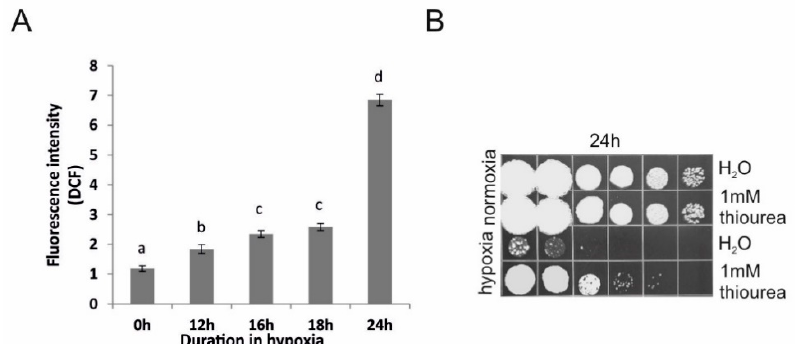
Figure 5. Production of ROS induce cell death under limited aeration. ( A ) ROS generation determined by measurement of DCF fluorescence. U. maydis cell suspensions (4 × 10 8 /mL) were incubated in water in 1.5 mL tightly sealed tubes for 12 h, 16 h, 18 h, and 24 h. For each time-point, a separate tube was designated. Error bars indicate standard deviations of four independent measurements. Significant differences ( p < 0.05) between control cells and cells in hypoxia are depicted by different letters. ( B ) Survival of U. maydis high-dense cell suspension (4 × 10 8 /mL) incubated for 24 h in water and in the presence of 1 mM thiourea. Normoxia depicted incubation in loosely capped 50 mL tubes, and hypoxia in 1.5 mL tubes; 10-fold serial dilutions were spotted on the solid growth medium. Experiment was performed three times and the representative result is shown.